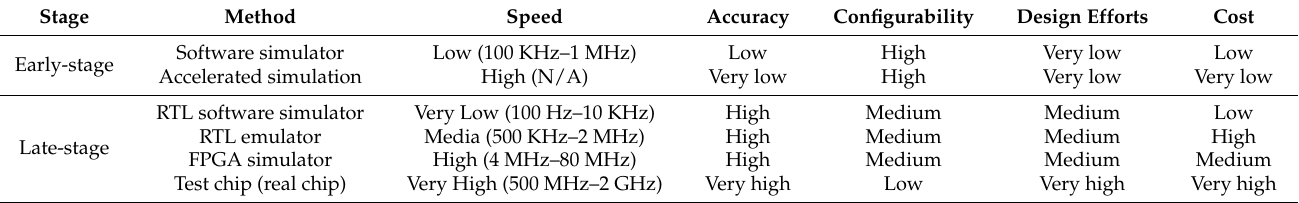
Table 1. Typical full system performance simulation methods for modern out-of-order